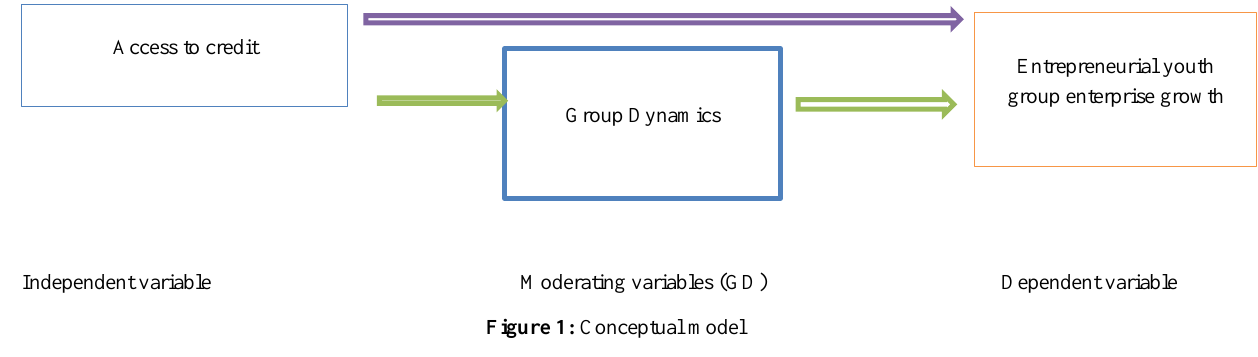
Figure 1: Conceptual